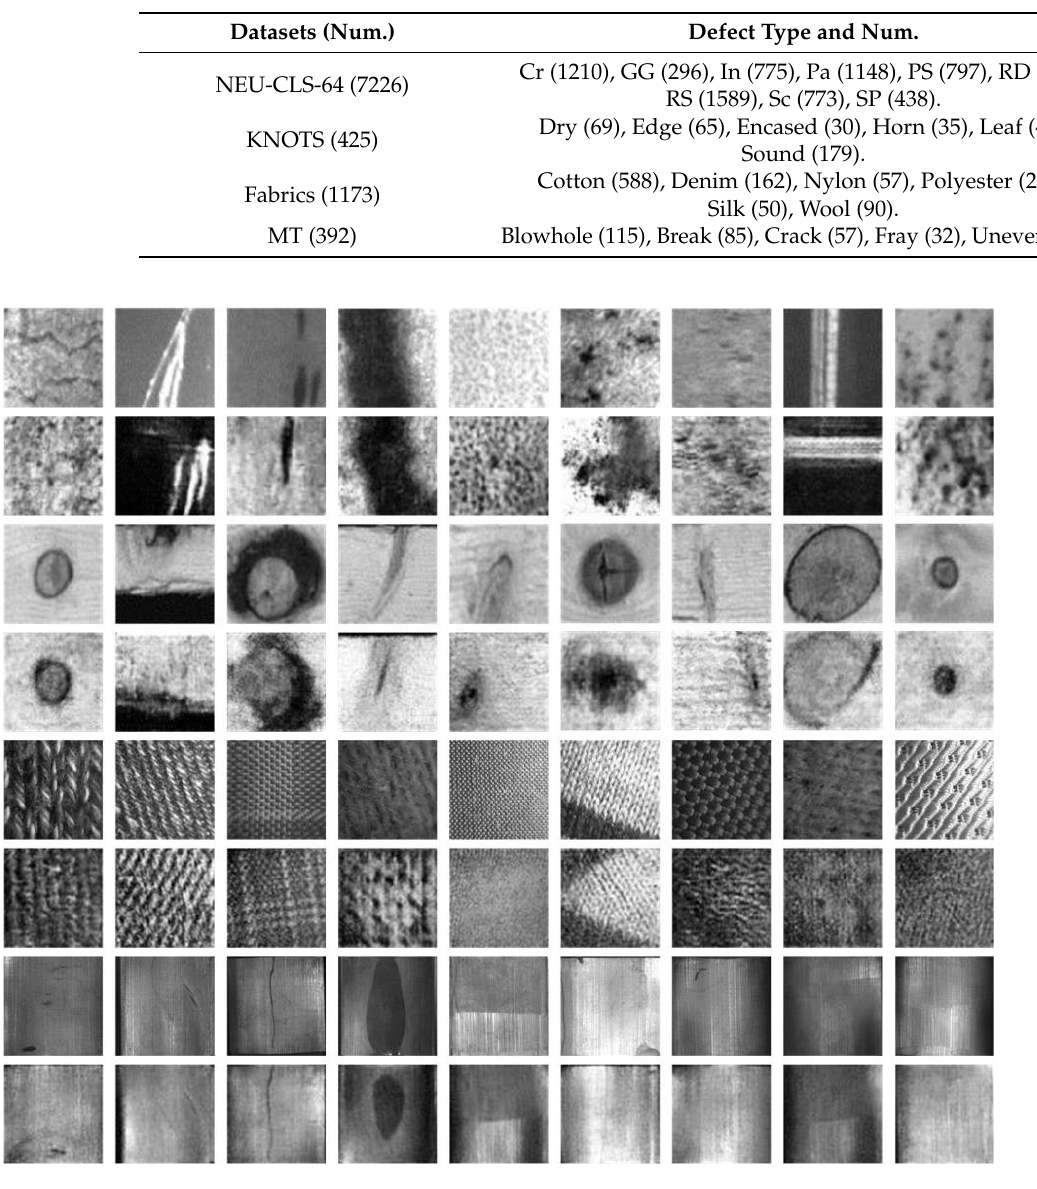
Figure 4. Examples of the real images and the GAN samples of the four defect datasets. In each group, the top row shows real images and the bottom row shows GAN samples. ( a ) NEU-CLS-64, ( b ) KNOTS, ( c ) Fabrics, ( d ) MT.